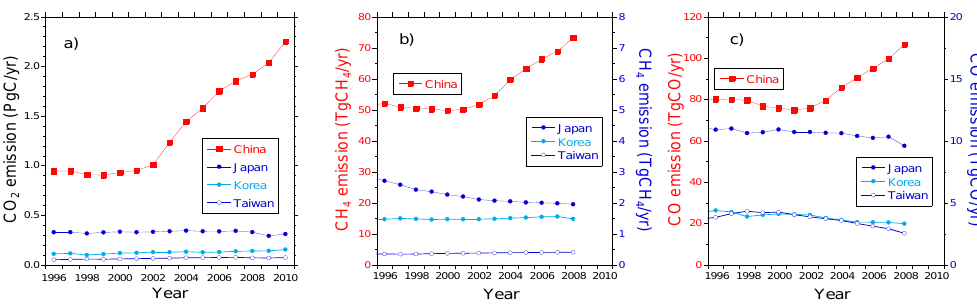
Fig. 1. Temporal changes in the estimated emissions of (a) fossil-fuel-derived CO 2 , (b) CH 4 , and (c) CO from China, Japan, Korea, and Taiwan. The CO 2 emissions are taken from the CDIAC database. CH 4 and CO emissions are taken from EDGAR v4.2. CH 4 and CO emissions from Japan, Korea and Taiwan are plotted against the right y